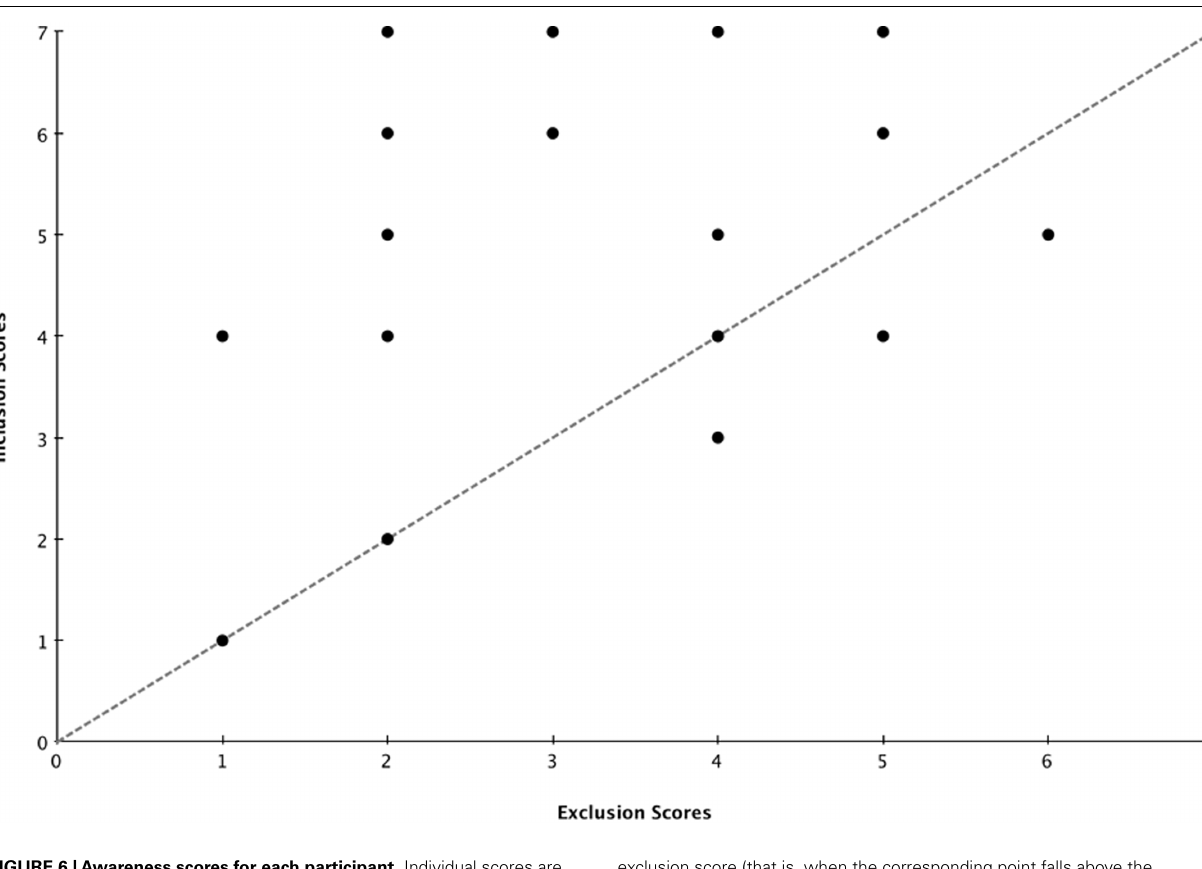
exclusion score (that is, when the corresponding point falls above the diagonal), participant’s knowledge can be considered to be at least partly conscious.When the inclusion score is smaller or equal to the exclusion score (the point falls below or on the diagonal), participant’s knowledge can be considered to be at least partly